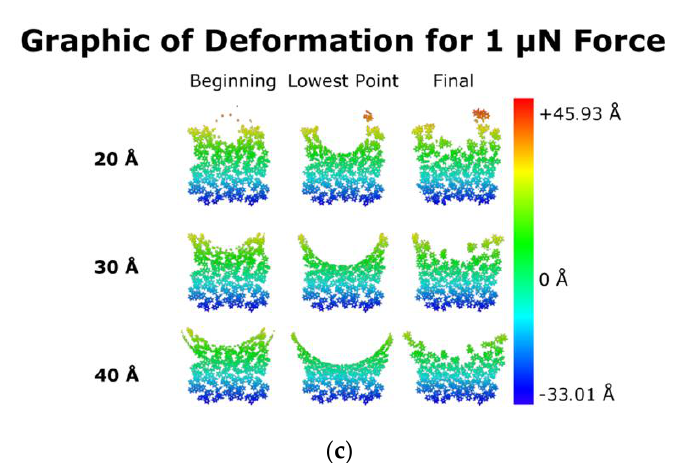
Figure 4. Cross-sectional view of imprint at ( a ) 100 nN, ( b ) 500 nN, and ( c ) 1 µN of force.